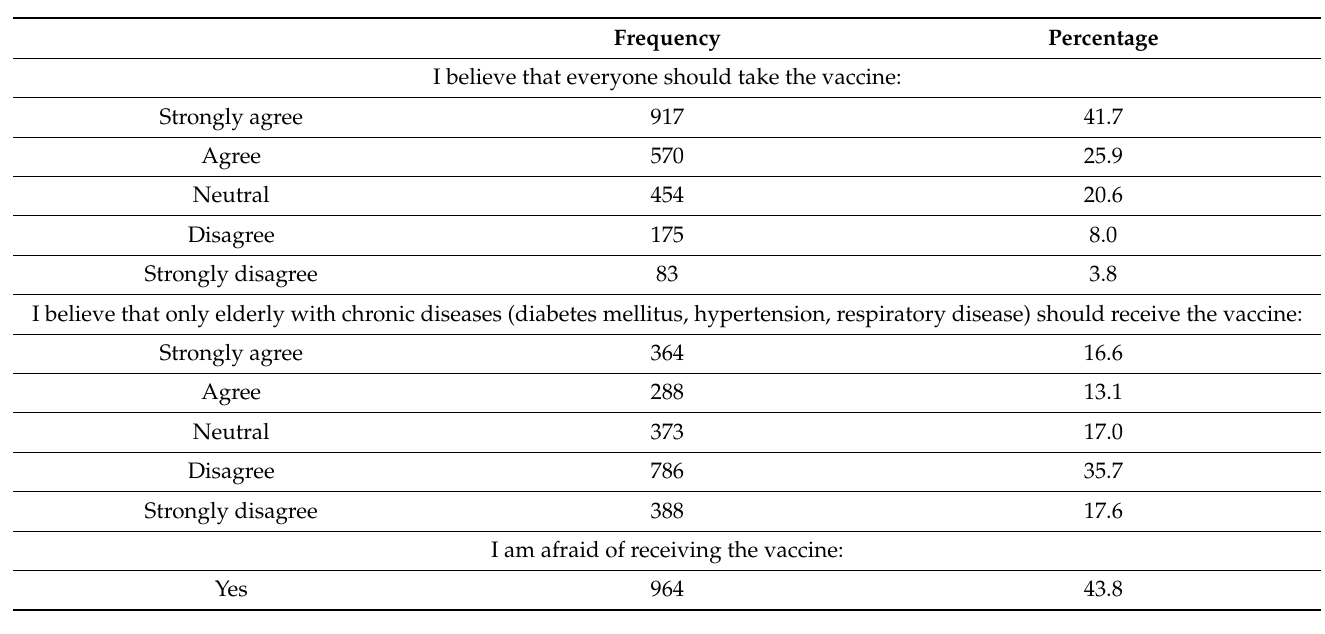
Table 4. The participants’ beliefs and worry regarding the vaccine.